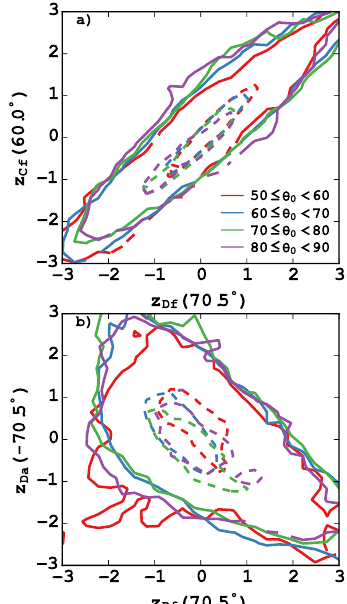
Figure 5. 50th (solid line) and 95th (dashed line) percentile con- tours of the joint probability distributions ( P(z i ,z j ) ) of NIR stan- dard scores (see Eq. 4) between MISR’s Df and Cf cameras (a) and between MISR’s Df and Da cameras (b) . These joint PDFs were calculated for four solar zenith angle